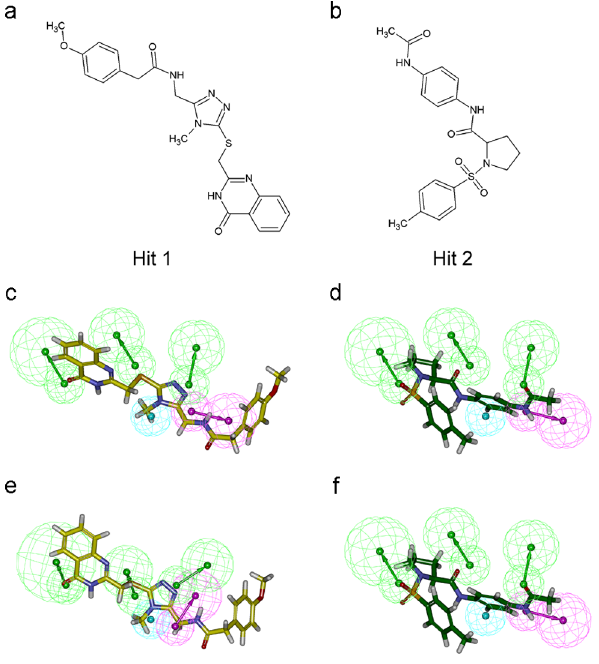
Figure 6. Final hit compounds and their pharmacophore overlay. The hit compounds depicted in stick representation. 2D chemical structures of (a) Hit 1 (BAS 13382537) and (b) Hit 2 (BAS 06350510). Mapping of (c) Hit 1 and (d) Hit 2 upon Pharm-P. Mapping of (e) Hit 1 and (f) Hit 2 upon Pharm-R.